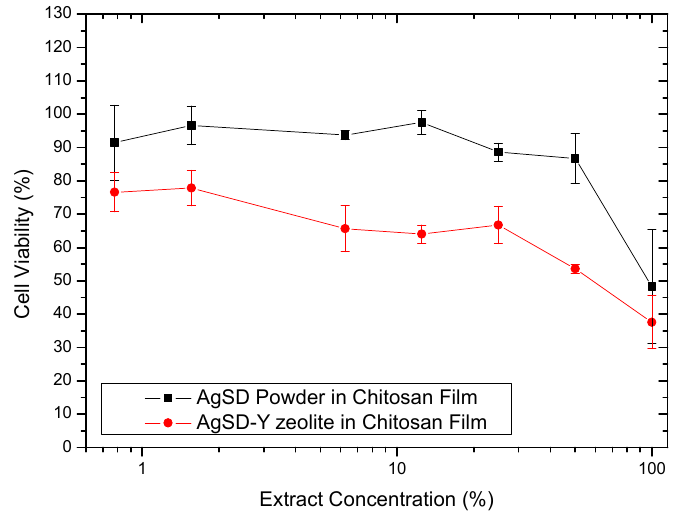
Figure 14. E ff ect of extract concentration on growth inhibition of Balb / c 3T3 fibroblasts with Figure 14. Effect of extract concentration on growth inhibition of Balb/c 3T3 fibroblasts with AgSD / Chitosan film and AgSD-Y / Chitosan AgSD/Chitosan film and AgSD-Y/Chitosan film.